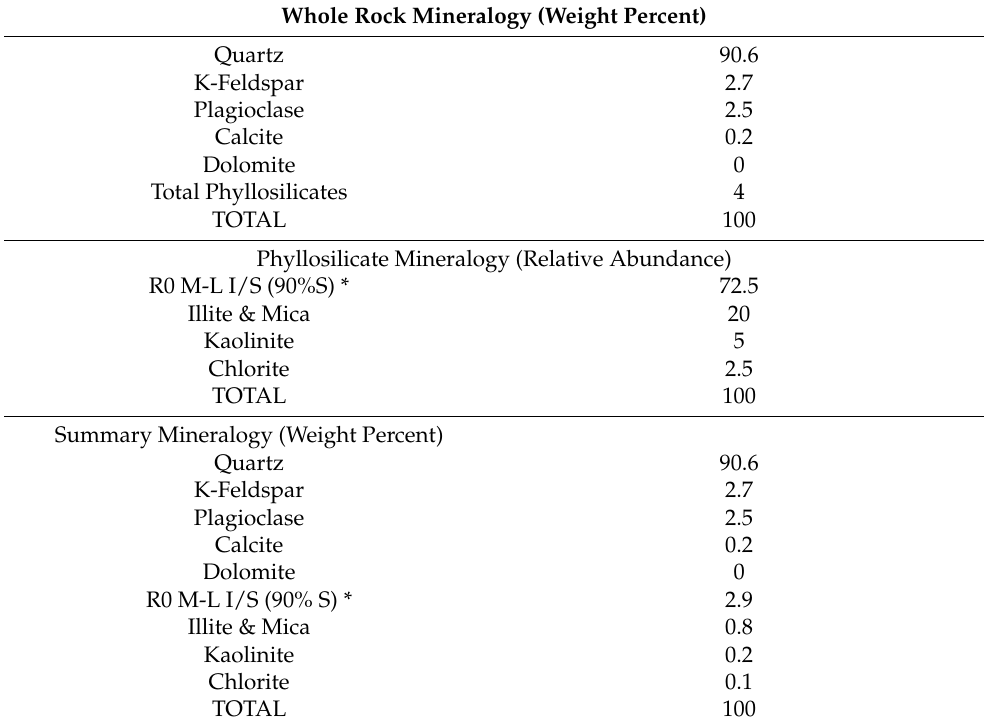
Table A6. XRD Analysis which shows mineral composition of